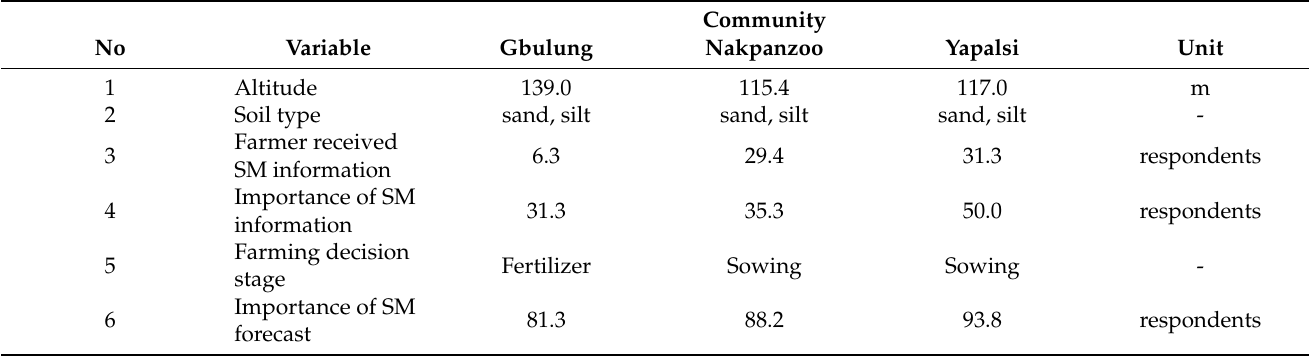
Table 2. Soil moisture information received by farmers and the importance of soil moisture in each